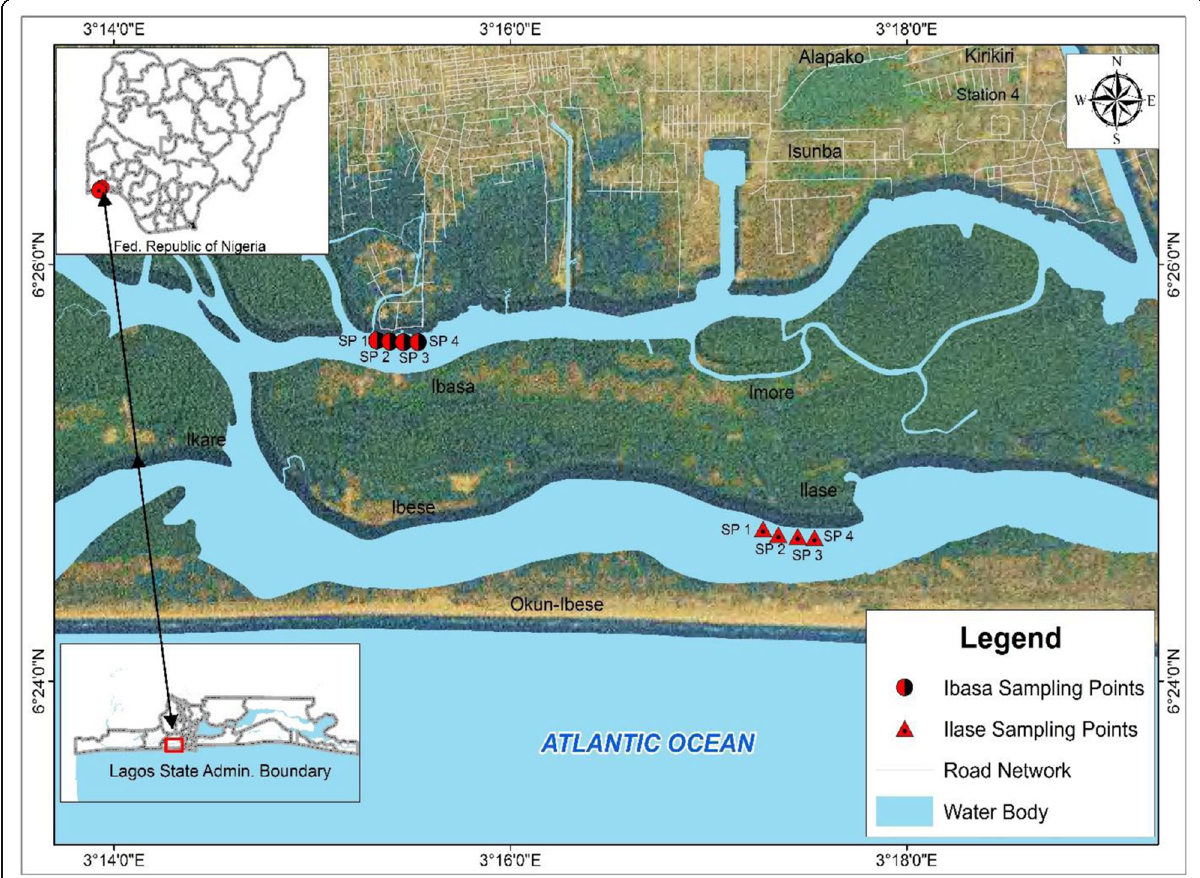
Fig. 1 Map showing the study site and sampling